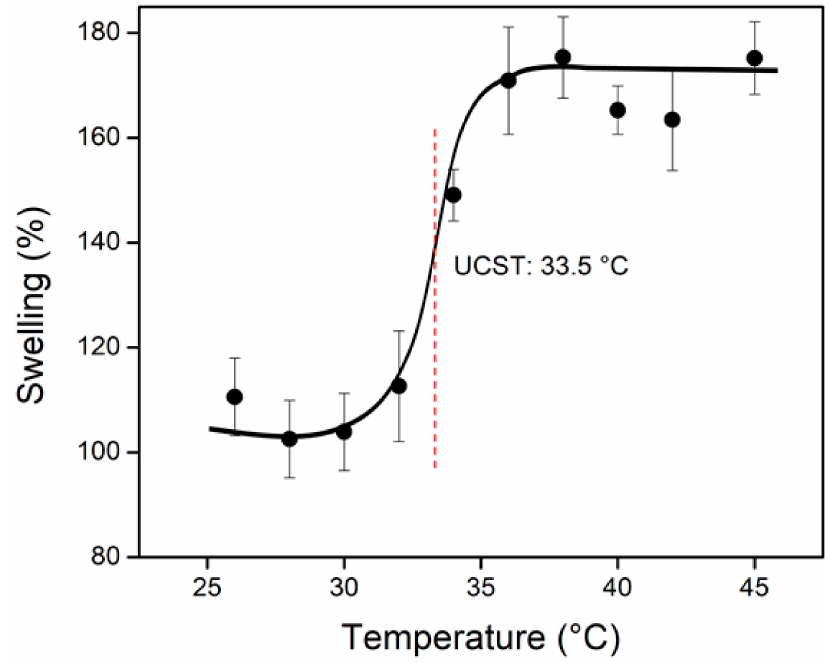
Figure 9. USCT of the binary grafted system ( net -CS)- g -NVCL/AAc (32% graft).